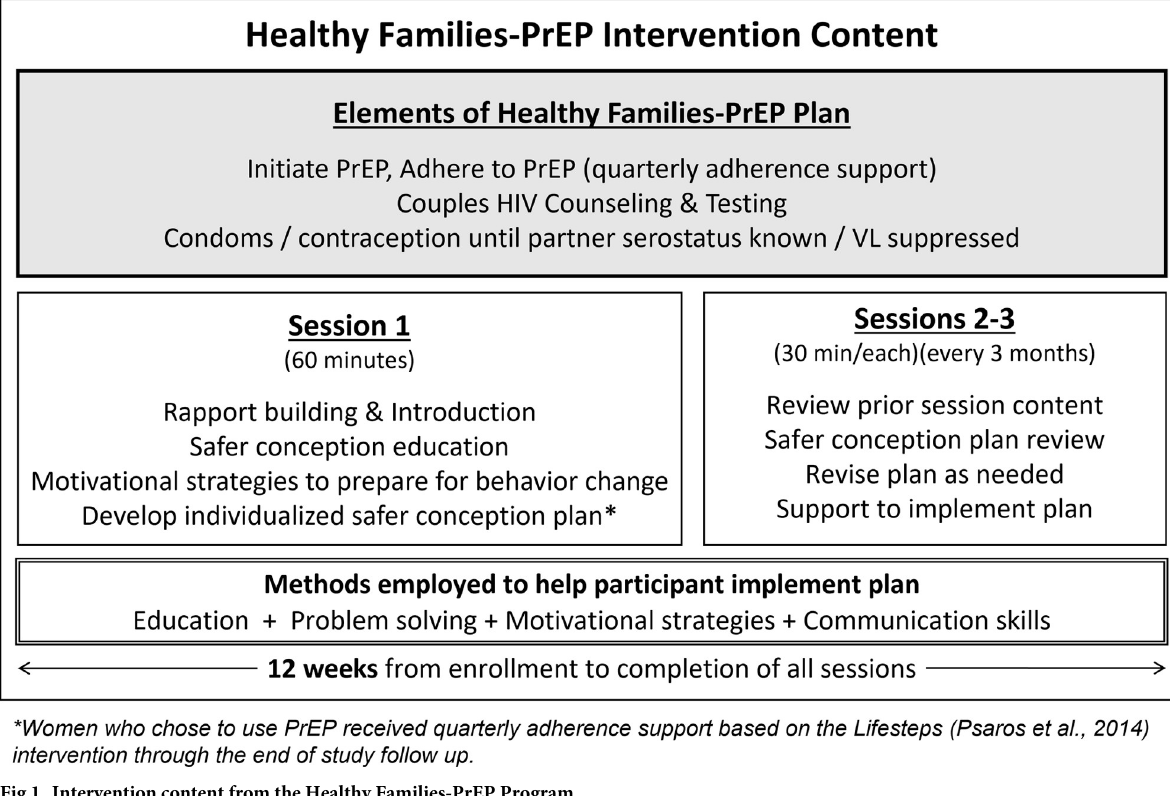
Fig 1. Intervention content from the Healthy Families-PrEP